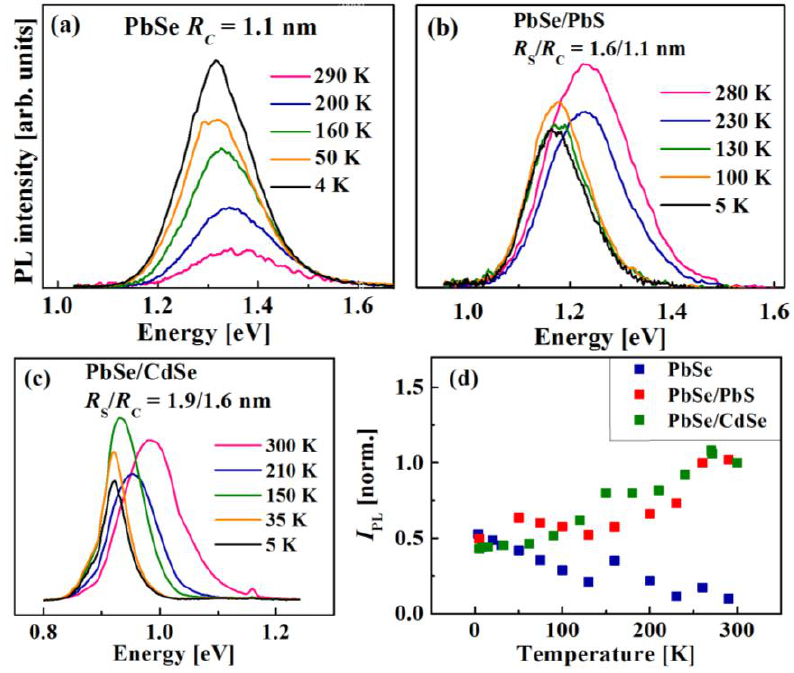
Figure 17. cw-PL spectra of QDs exposed to air for 20 min. ( a ) PbSe; ( b ) PbSe/PbS, and ( c ) PbSe/CdSe QDs with different R S /R C values (see the legends); ( d ) dependence of I PL on temperature for the same QDs as in ( a – c ), exposed to air for 20 and 50 min.